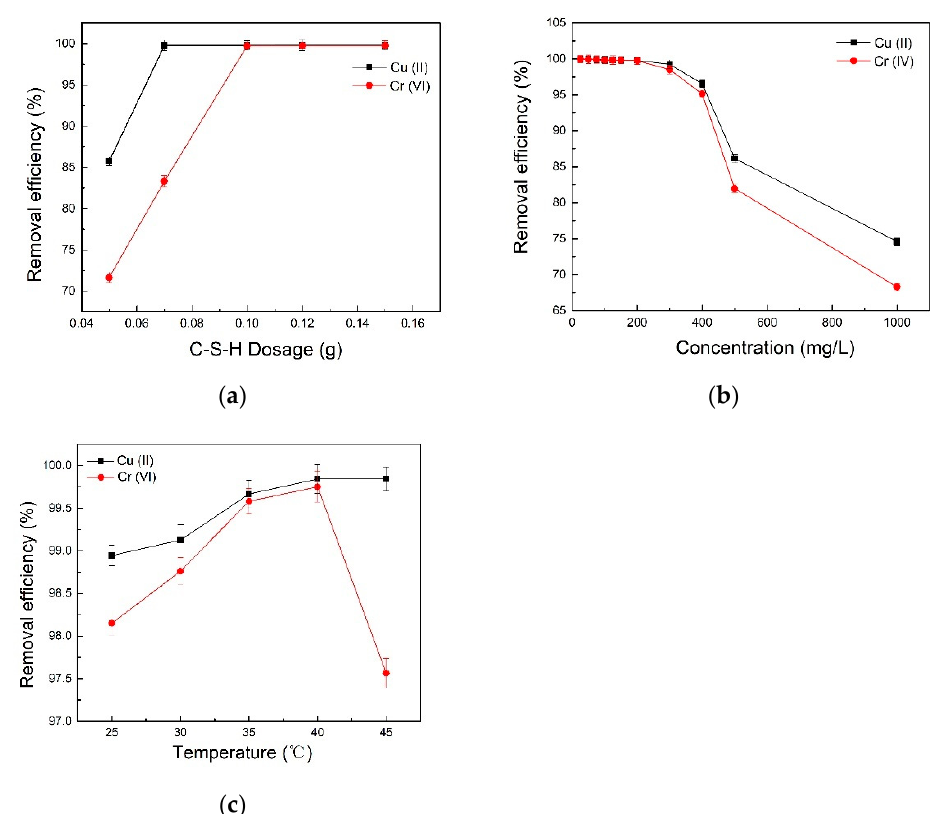
Figure 2. Effect of C-S-H dosage, initial sorbent concentration and temperature onto C-S-H (( a ), 90 min, 40 °C, [Cr(VI)] 0 = [Cu(II)] 0 = 200 mg/L, pH 2 for Cr(VI), pH 6 for Cu(II)); ( b ), 40 °C, 90 min, pH 2 and 0.1 g C-S-H for Cr(VI), pH 6 and 0.07 g C-S-H for Cu(II); ( c ), [Cr(VI)] 0 = [Cu(II)] 0 = 200 mg/L, 90 min, pH 2 and 0.1 g C-S-H for Cr(VI), pH 6 and 0.07 g C-S-H for Cu(II)).